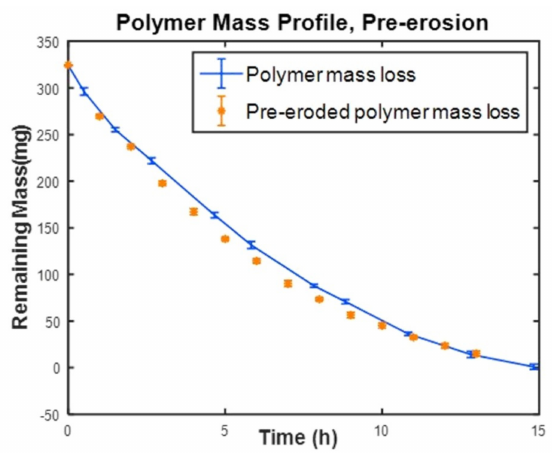
Figure 7. Pre-erosion of PAH tablets to eliminate the induction period. The tablets were pre-eroded for 8h and vacuum-dried before subjected to mass loss experiments at 37 ◦